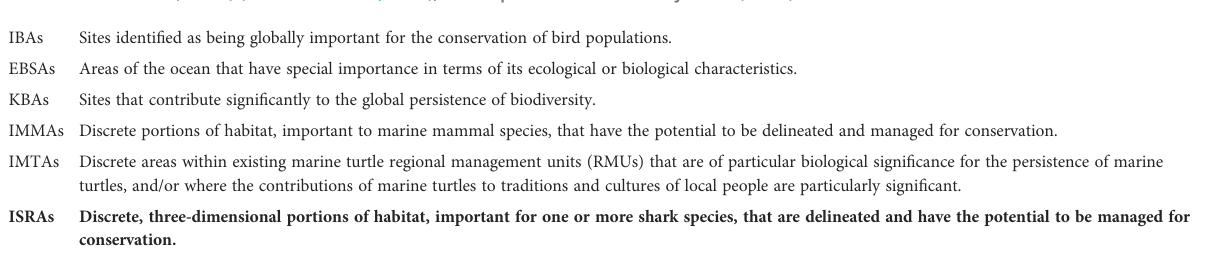
TABLE 1 De fi nitions of Important Bird and Biodiversity Areas (IBAs) (Donald et al., 2019), Ecologically or Biologically Signi fi cant Areas (EBSAs) (Clark et al., 2014), Key Biodiversity Areas (KBAs) (Eken et al., 2004), Important Marine Mammal Areas (IMMAs) (Corrigan et al., 2014), Important Marine Turtle Areas (IMTAs) (Bandimere et al., 2021), and Important Shark and Ray Areas (ISRAs). Sites identi fi ed as being globally important for the conservation of bird